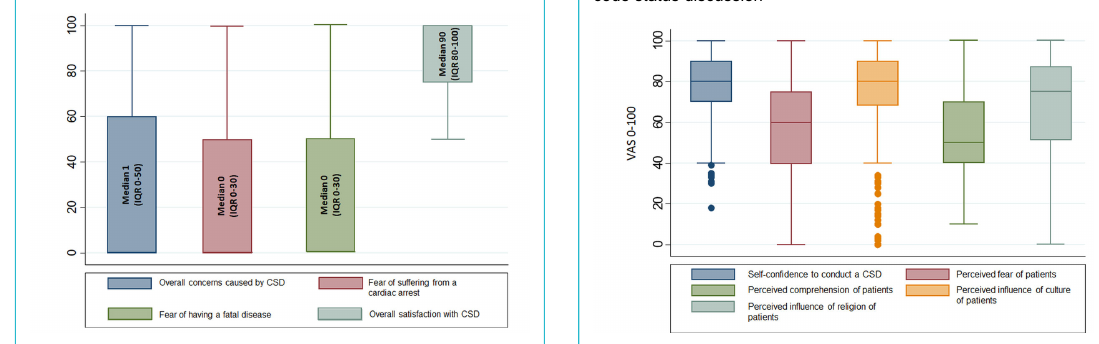
Figure 1b: Box-plots with median values of physicians’ rating of perceived own self-confidence to conduct a code status discussion as well as perceived challenges of code status discussions. CSD = code status